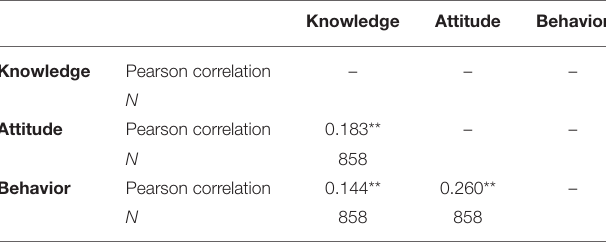
TABLE 2 | Correlation between previously recorded knowledge, attitude, and behavior